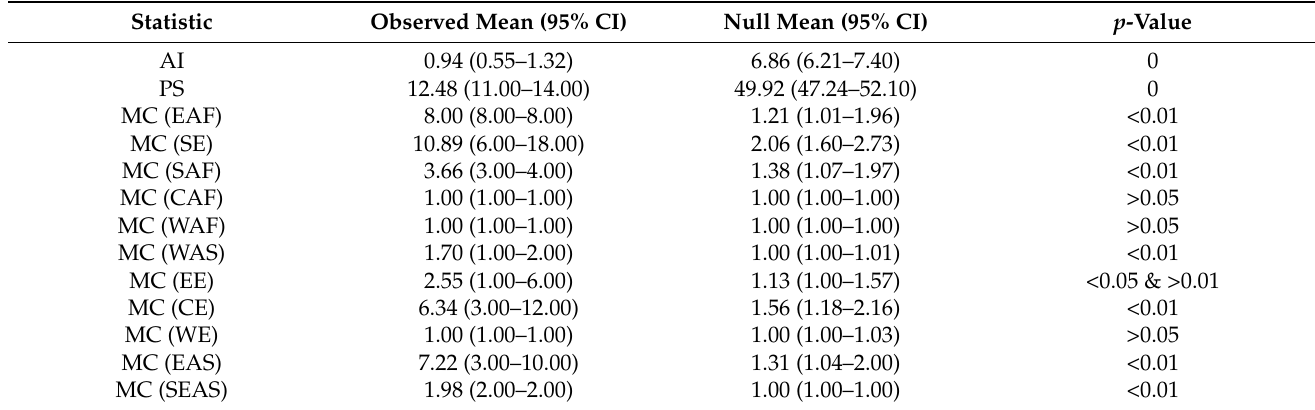
Table 2. Phylogeny–trait association test of the geographic structure of ASFV by Bayesian Tip- Significance